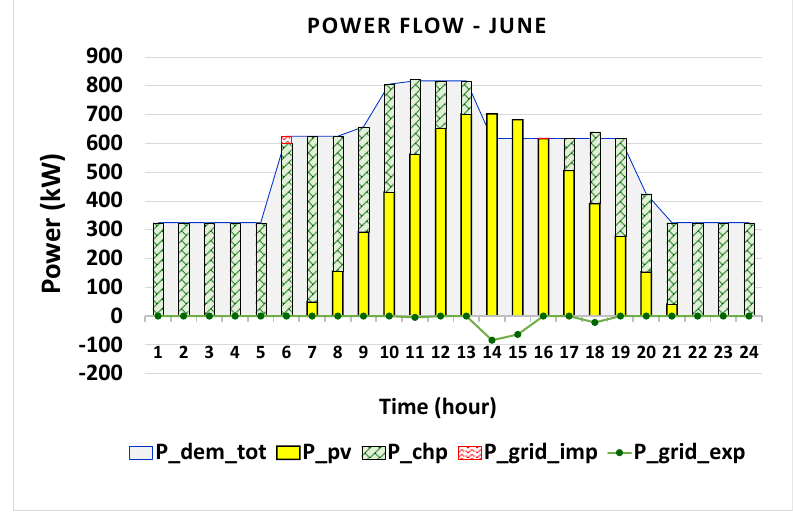
Figure 11. The power from/to the grid (P_grid_imp/P_grid_exp), power generated by the CHP and solar PV (P_chp & P_pv), and total power demand (P_dem_tot).